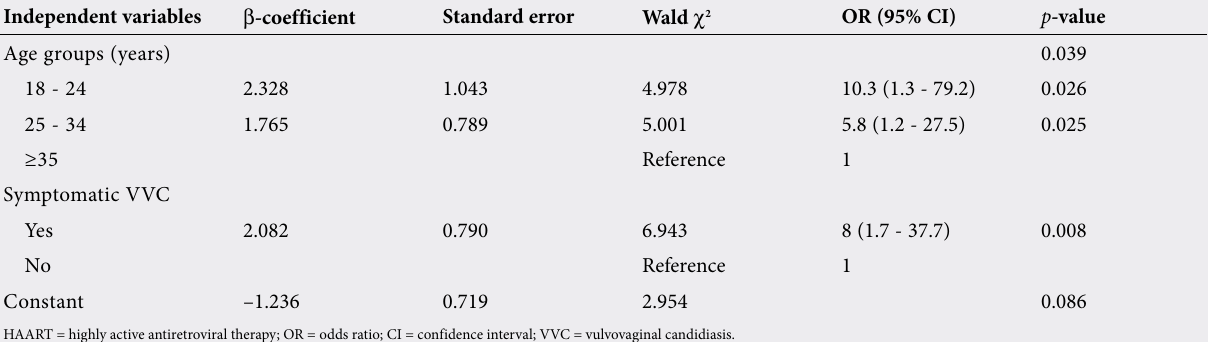
Table 3. Independent determinants of plasma HIV RNA levels in HIV-infected women receiving HAART * ( N